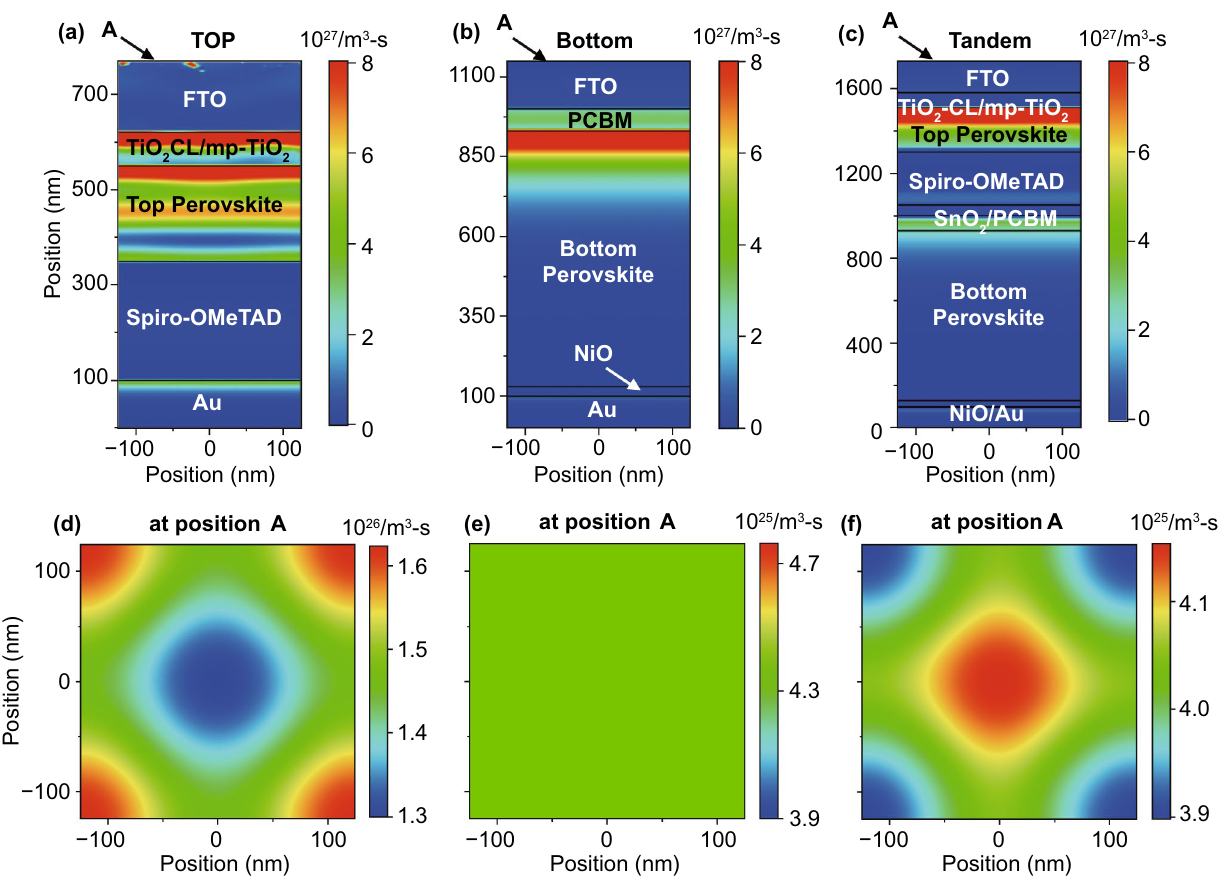
Fig. 6 Total generation rate of a single‑junction top perovskite (wide E g ) solar cell, b single‑junction bottom perovskite (narrow E g ) solar cell, and c perovskite/perovskite tandem solar cell. d‑f Corresponding top‑view of the generation rate. The top perovskite absorber has a thickness of 210 nm, and the bottom perovskite absorber has a thickness of 800